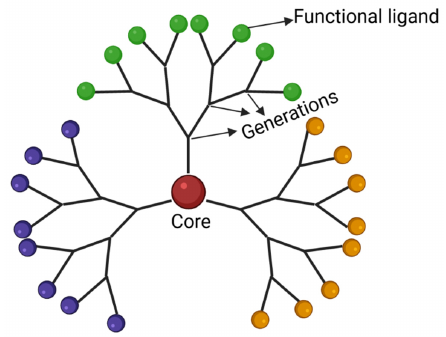
Figure 2 . Dendrimers are NPs whose building blocks extend out in generations from a central core. The surfaces of these tree-like structures can be conjugated with a number of functional ligands that can target BBB and tumor receptors and carry chemotherapeutic